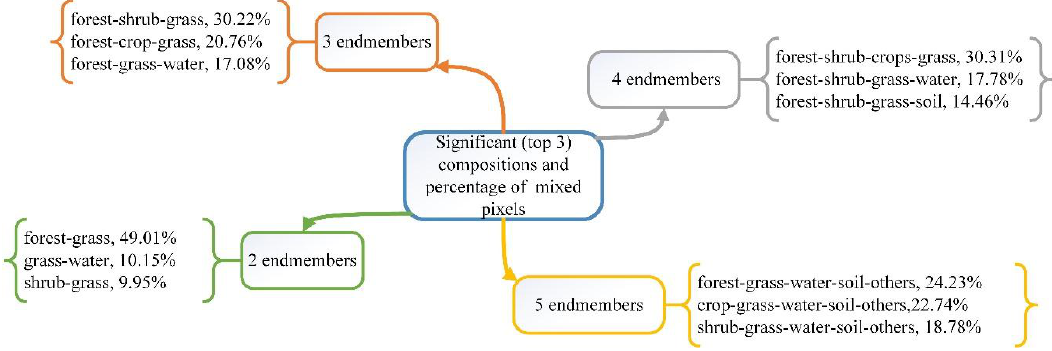
Figure 6. Significant combinations of 1-km resolution mixed pixels with two to five end members.